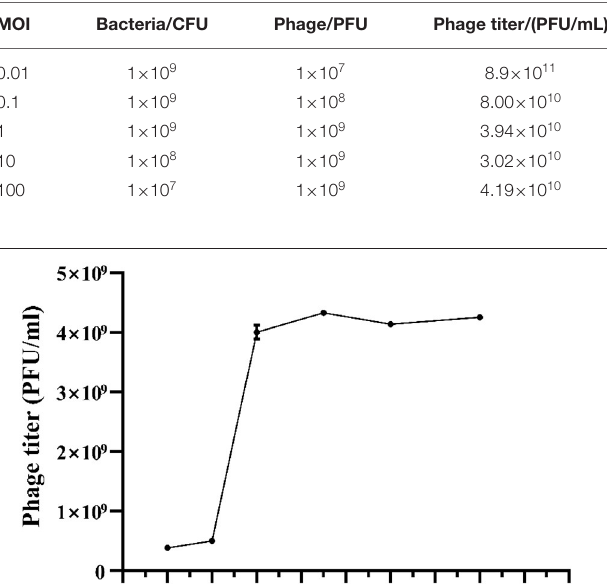
10 nm, a short tail approximately 16 nm in length ( Figure 1B ). The phage belongs to the family Siphoviridae